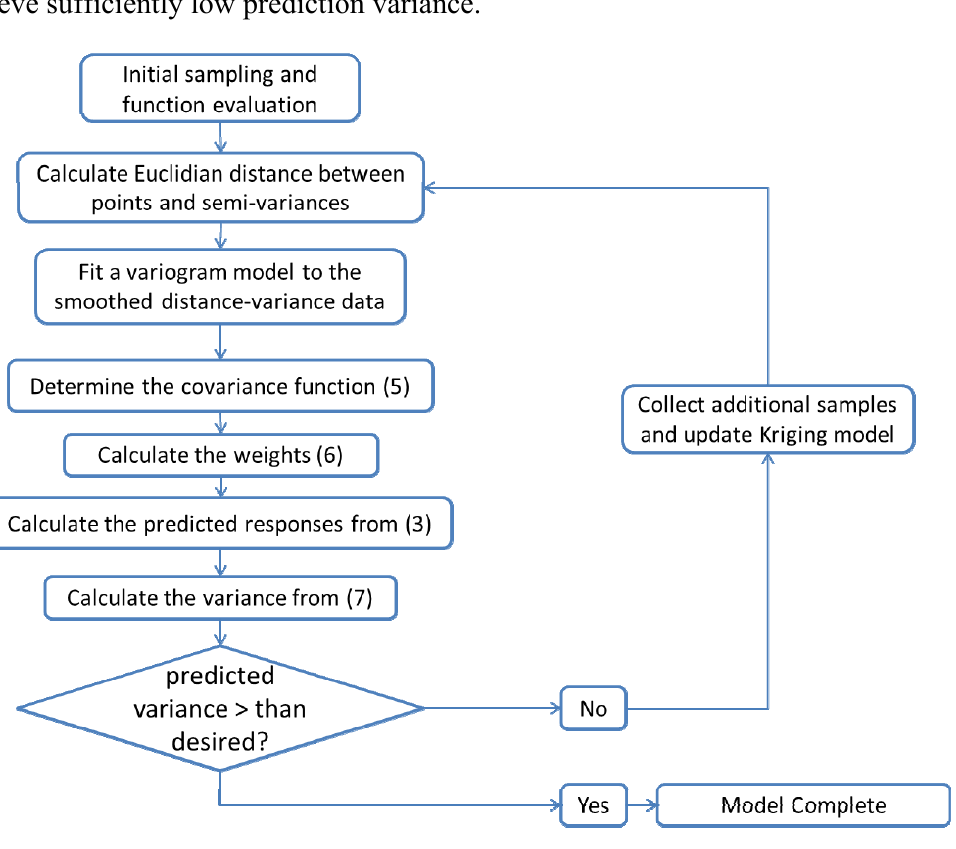
Figure 2. Algorithm for Kriging with the option for updating the sampling space in order to achieve sufficiently low prediction